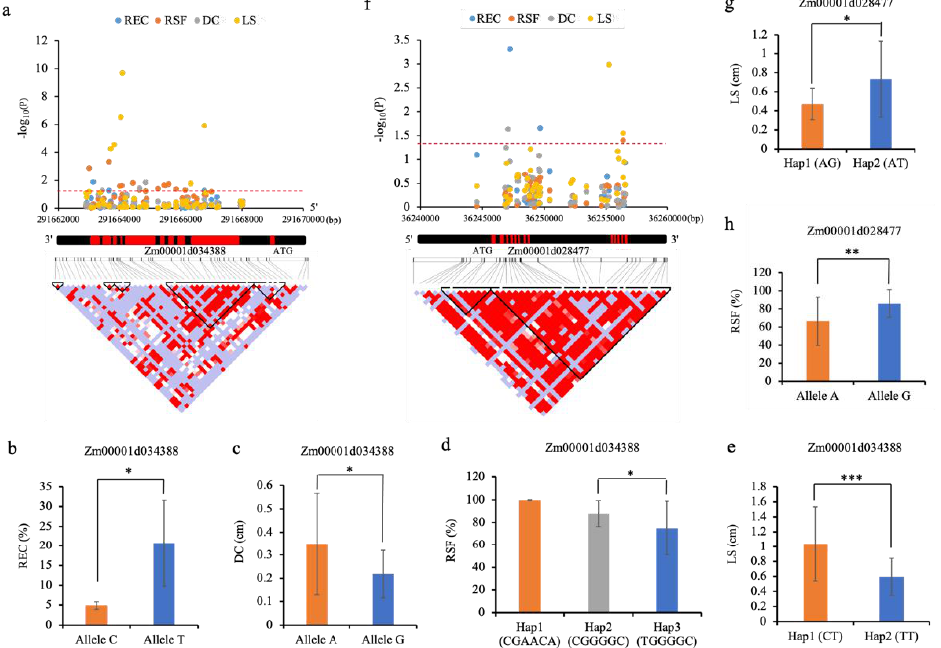
Figure 5. Hub gene-based association mapping. ( a , f ) Manhattan plots (top) and LD heat maps (bottom) of Zm00001d034388 and Zm00001d028477. The significance threshold is shown as a red dashed line ( p < 0.05). The gene structure is shown in the middle. The exons are represented by filled red boxes. ( b – e ) Differences in ( b ) REC (rate of embryogenic callus), ( c ) DC (diameter of callus), ( d ) RSF (rate of shoot formation), and ( e ) LS (length of shoot) between alleles or haplotypes of Zm00001d034388. ( g , h ) Differences in ( g ) LS and ( h ) RSF between alleles or haplotypes of Zm00001d028477. Statistical significance is determined by two-tailed t -test: *, **, and *** denote significance at p = 0.05, p = 0.01, and p = 0.001 levels, respectively.